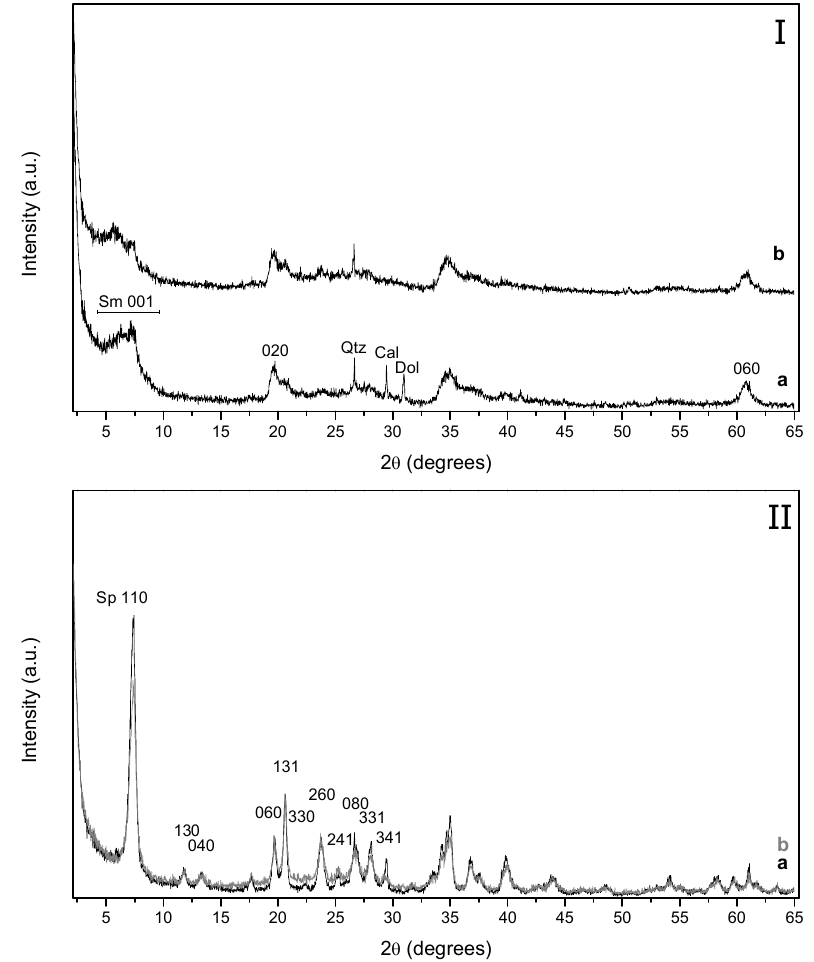
Figure 2. ( I ): XRD patterns of starting Sm ( a ) and Sm–H ( b ). ( II ): Comparison of XRD patterns of starting Sp ( a , black) and Sp–H ( b , grey).